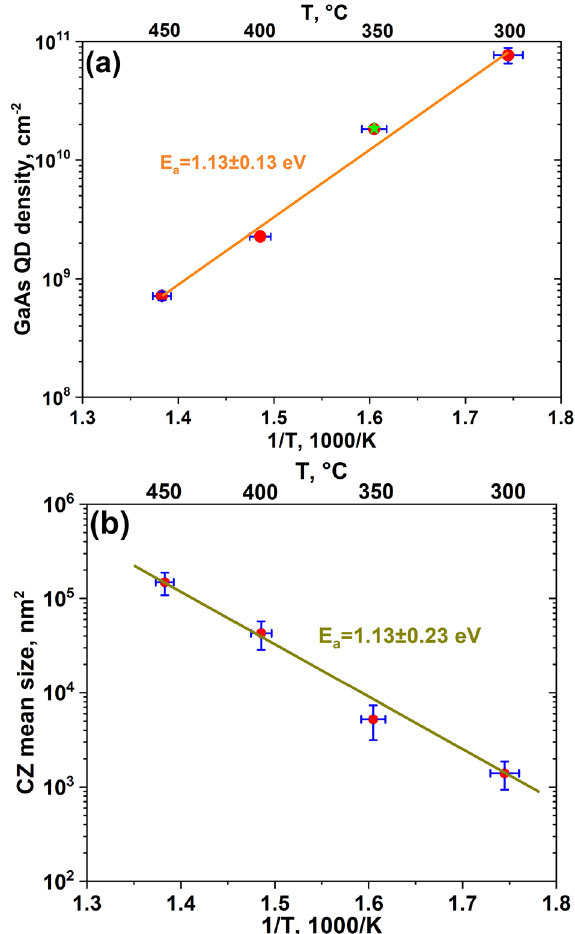
Figure 2. (a) The temperature density dependence of DE GaAs islands grown on GaAs(111)A substrate (red points). The green star indicates the island density of the sample T2b. The nucleation activation energy, E a = 1.13 ± 0.13 eV . (b) The temperature dependence of a mean size of Voronoi cells. The activation energy E a , calculated from this method, equals 1.13±0.23 eV. The temperature error bar for both graphs is ± 5 ◦ C